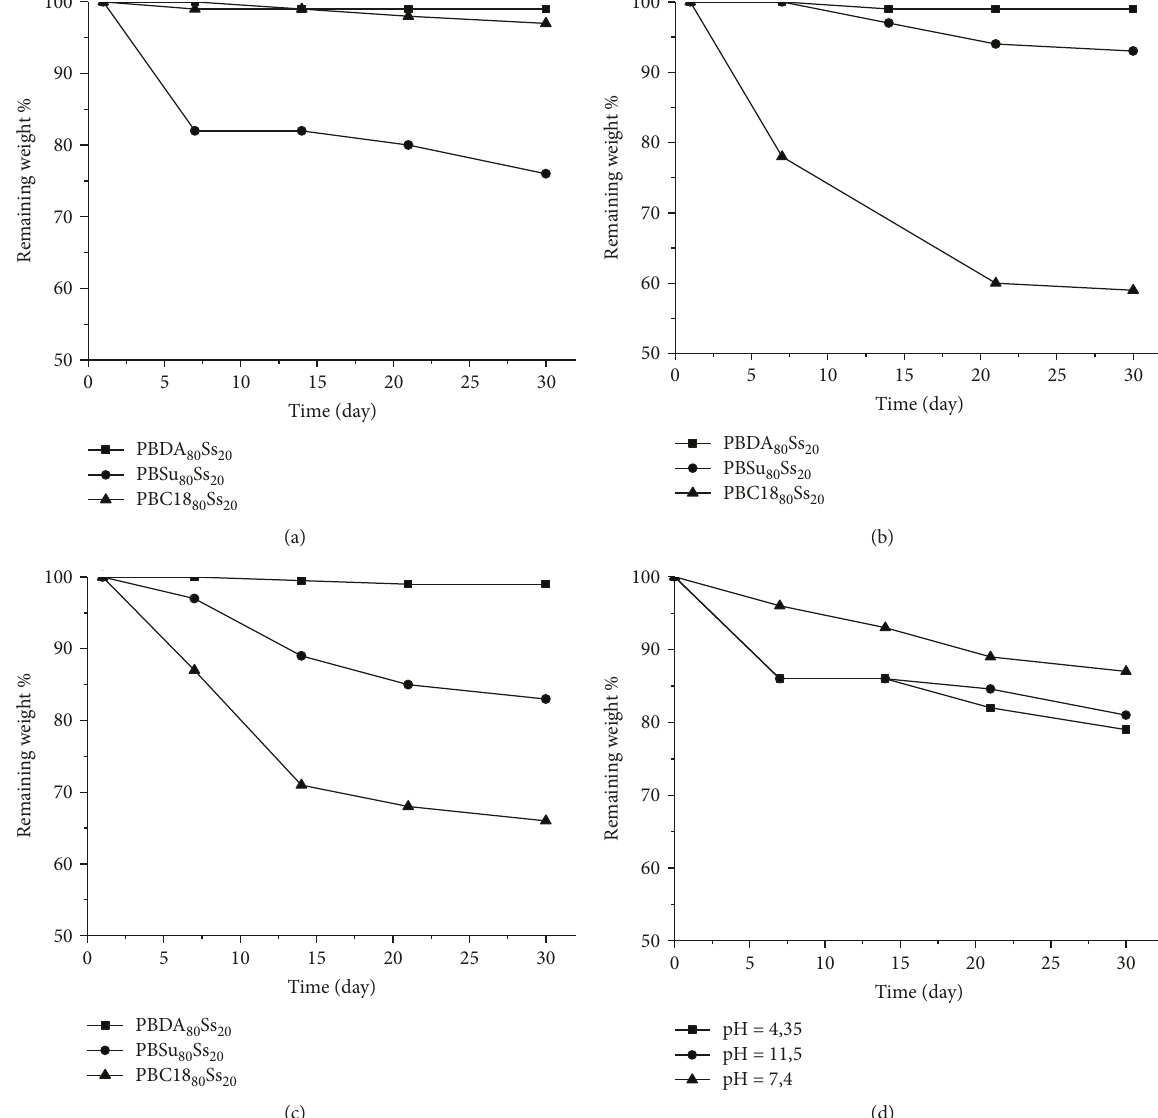
Figure 17: Hydrolysis of PBSu (b) at pH = 7 4 , and (c) at pH = 11 5 . Comparison with (d) “ remaining weight ” of cPBSu pH = 7 4 ) at 37 °